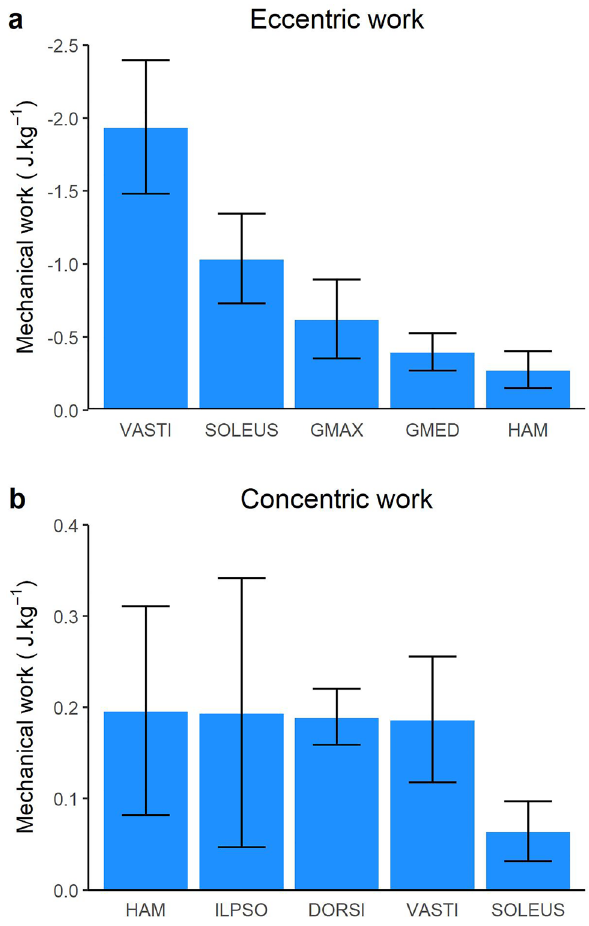
Figure 3. Mean (bars) and SD (error bars) body mass normalised lower limb musculotendinous eccentric ( a ) and concentric ( b ) mechanical work across the landing phase (initial contact to peak knee flexion) of a single-leg drop landing from a 0.31 m height. VASTI, vasti (sum of vastus intermedius, lateralis and medialis); SOLEUS, soleus; GMAX, gluteus maximus; GMED, gluteus medius (sum of gluteus medius and minimius), HAM, biarticular hamstrings (sum of biceps femoris long head, semimembranosus, and semitendinosus); ILPSO, iliopsoas (sum of iliacus and psoas major); DORSI, ankle dorsiflexors (sum of tibialis anterior, extensor hallucis and digitorum